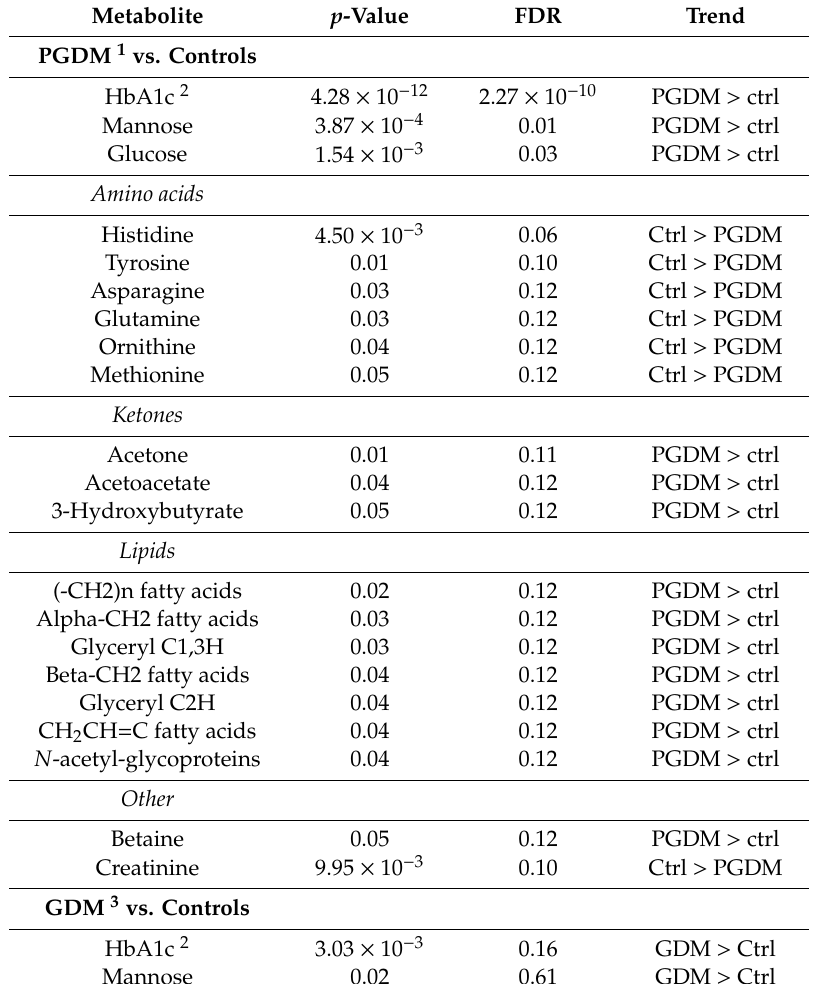
Table 5. Metabolites Significantly Altered in Maternal Serum in PGDM or GDM during the Immediate Post-Partum